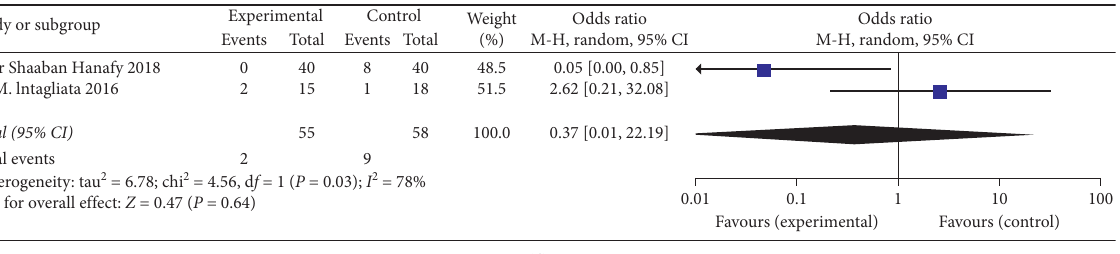
Figure 5: Therapeutic effects of direct oral anticoagulants vs. traditional anticoagulants (Experimental group: direct oral anticoagulant; Control group: traditional oral anticoagulant): (a) analysis of recanalization rate; (b) bleeding events; (c) analysis of bleeding events after random effects were combined; (d) other adverse events; (e) analysis of other adverse events after random effects were combined; (f) analysis of death events after random effects were